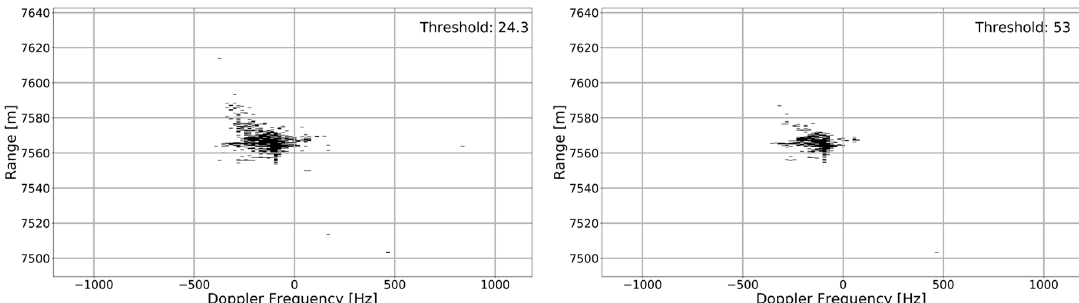
Figure 19. Binary detection map in range-Doppler domain using ( a ) K-distribution and ( b ) K-Rayleigh distribution. The thresholds estimated in both the cases are shown on the top right. The X-band HH F-SAR data were used as an input. The detection maps were generated using 128 azimuth and 512 range samples, the desired false alarm rate was set to P fa = 10 − 6